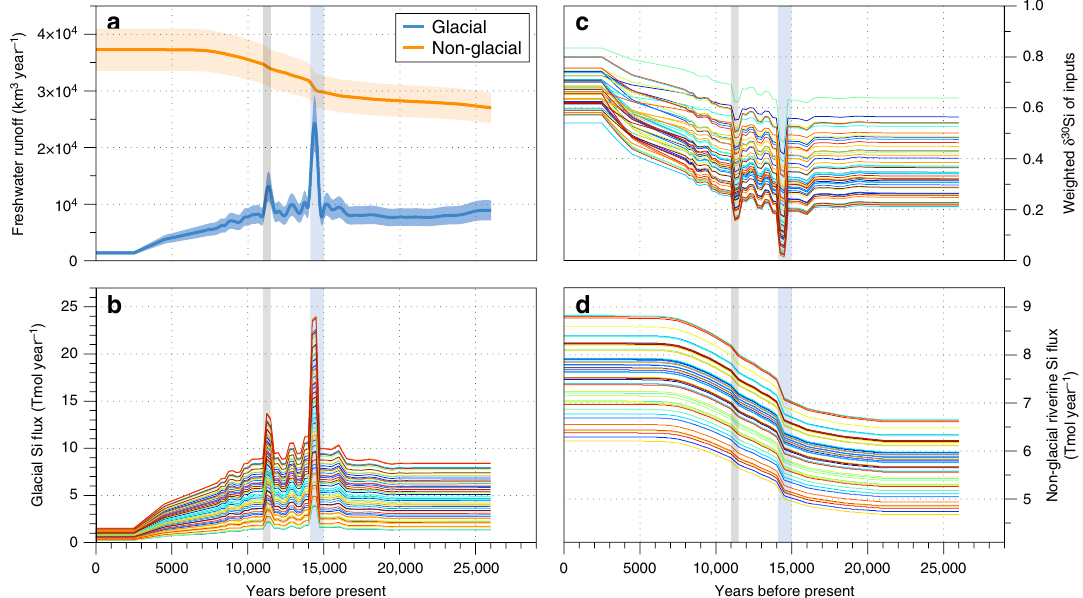
Fig. 4 Freshwater fl ux estimates and model input comparison. a Freshwater fl uxes from glacial and nonglacial sources, with estimated uncertainty given in the orange- and blue-shaded regions, and b the glacial DSi + ASi input fl ux, c weighted δ 30 Si composition of the Si input fl ux and d nonglacial riverine DSi + ASi input fl ux over each model simulation. Coloured lines correspond to the model simulations in Fig. 5. Additional input data are detailed in Supplementary Table 1. Meltwater Pulse 1a (MWP1a) is highlighted by the shaded blue region, and Meltwater Pulse 1b (MWP1b) by the shaded grey region